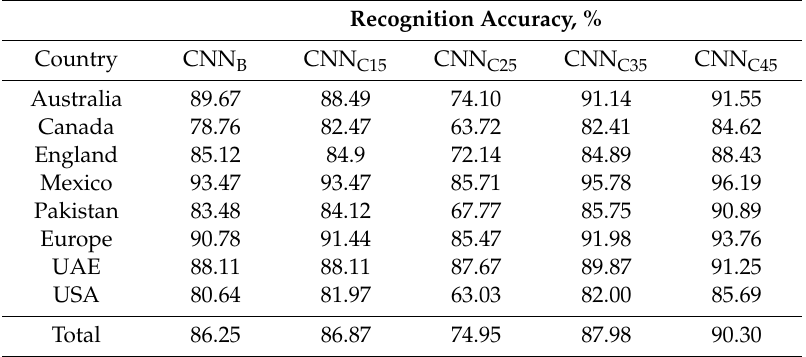
Table 4. Performance comparison of base CNN with modified CNN structures. Recognition Accuracy,